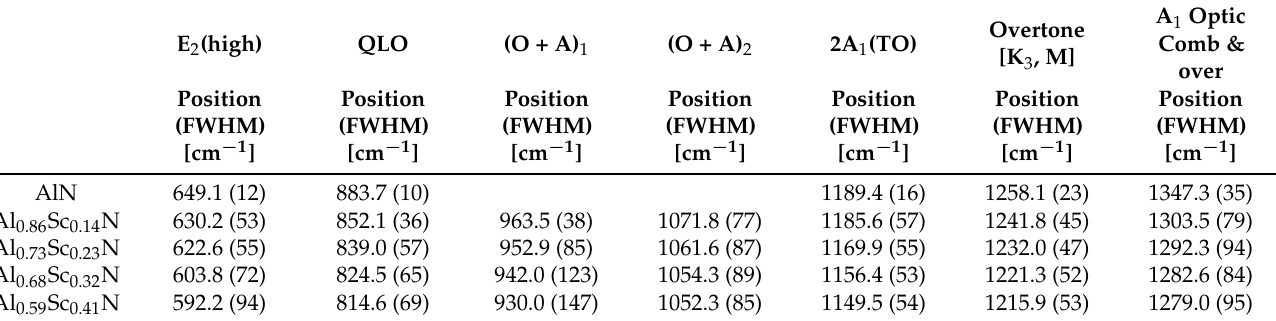
Table 1. Peak position and linewdith (FWHM) of the Raman-active bands collected from the AlScN films with the various Sc